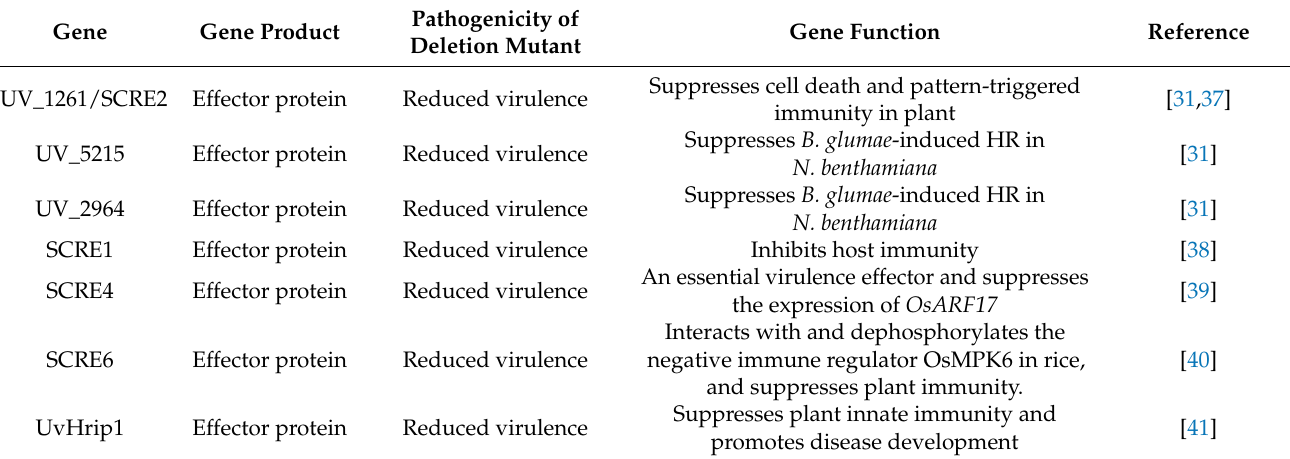
Table 1. Effectors characterised in Ustilaginoidea virens